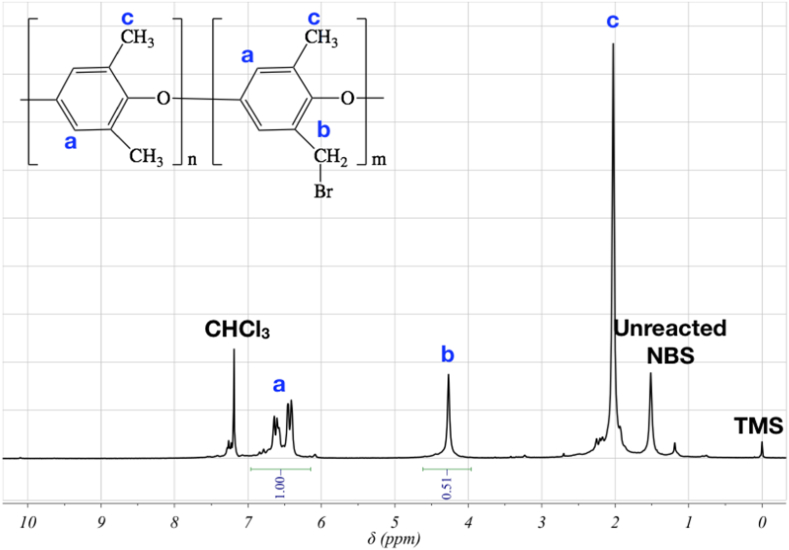
1H NMR spectrum of BrPPO.